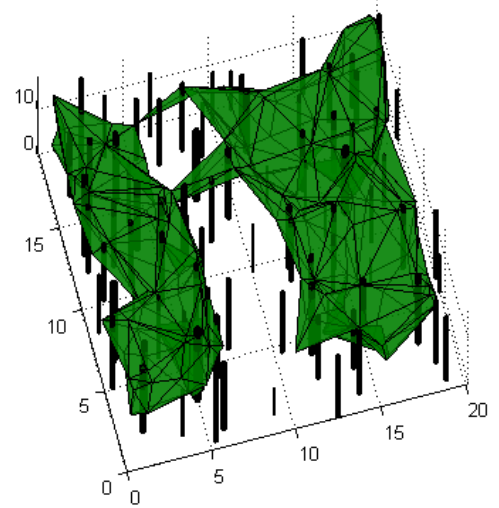
Figure 4. Canopy elements produced by the persistent homology approach vs. tree stems observed within the area of an example